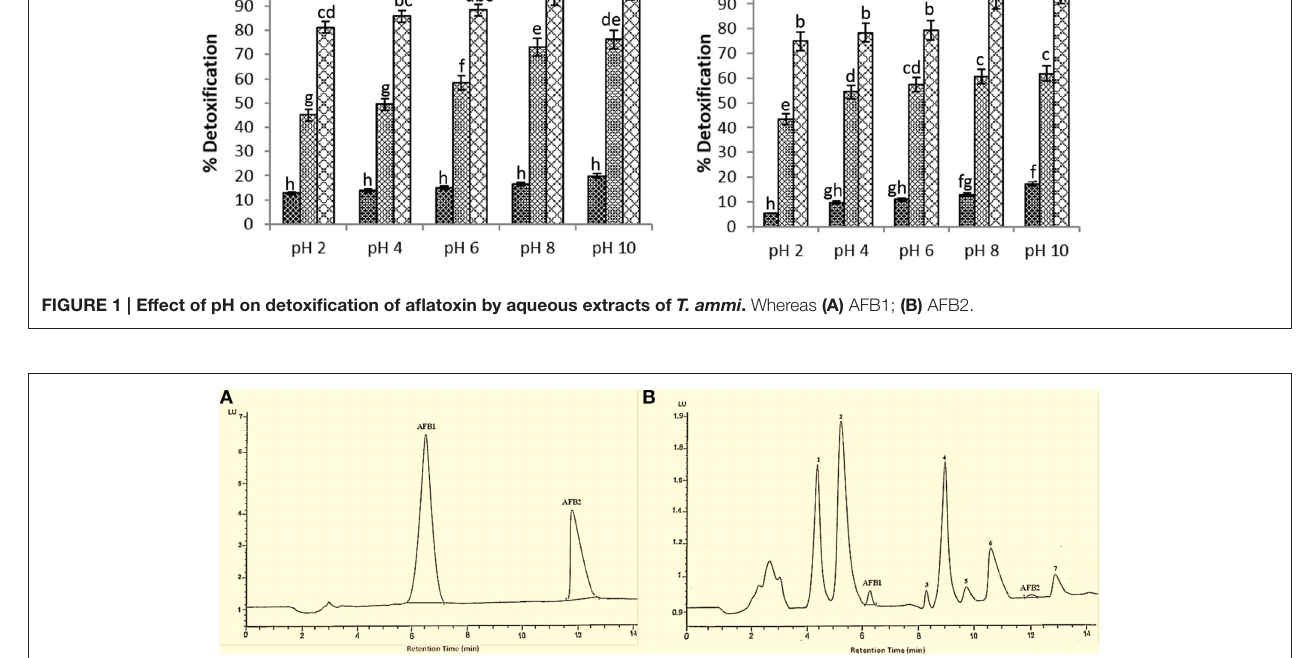
FIGURE 2 | HPLC chromatogram of AFB1 and AFB2. Whereas (A) untreated toxins; (B) toxin treated with T. ammi seeds extract at 30 ◦ C and pH 8.